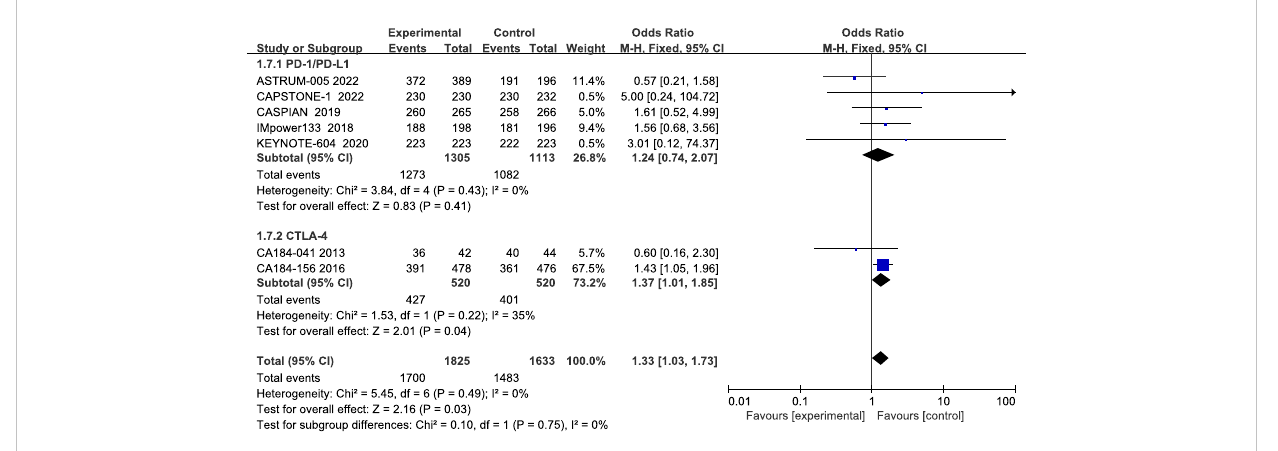
FIGURE 8 Forest plot of all grade AEs comparison between ICIs combined with chemotherapy and chemotherapy alone and subgroup